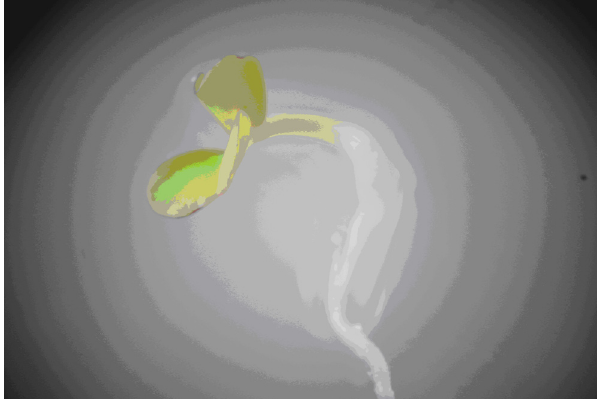
Fig. 5. Normal, mature embryo derived from microspore (40x)